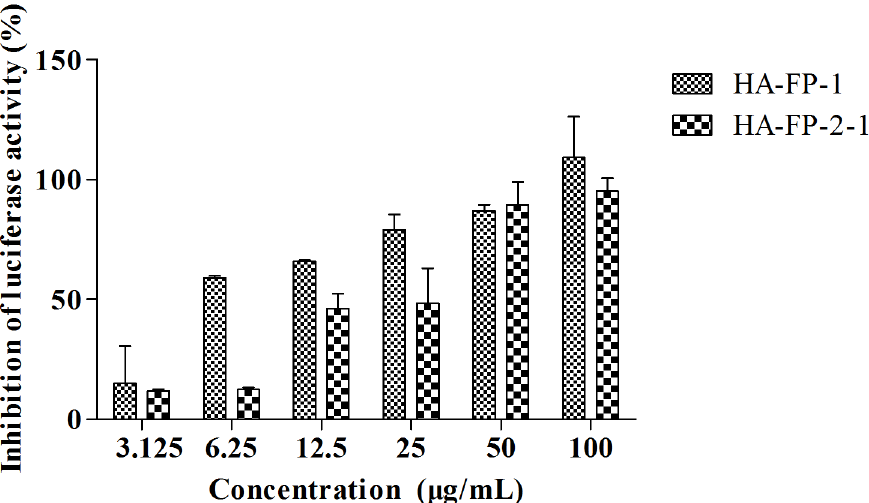
Fig 2. Inhibitory effect of pFPs against influenza A pseudovirus. The plasmids encoding HA and NA of A/ Thailand/Kan353/2004 were used to prepare H5N1 pseudoviruses. To measure the inhibitory effects of tested peptides, MDCK cells (1 × 10 4 /well) were seeded in 96-well plates and grown overnight. The peptides in various concentrations were incubated with pseudo-typed particles for 30 min at 37°C, then transferred to the MDCK cells and incubated for an additional 48 h. The luciferase activity expressed by pseudo-virus was measured. CL-385319 at 50 μ M was used as a positive control, wells without peptides as a negative control.